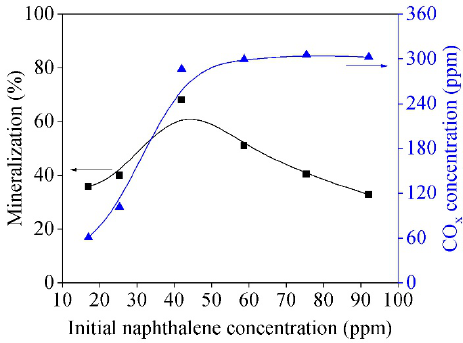
Figure 5. Effect of initial naphthalene concentration on the mineralization and CO x concentration in a DBD reactor filled with Al 2 O 3 . (Discharge power: 55 W; driving frequency: 12.6 kHz; initial naphthalene concentration: 21.5 ppm; total gas flow rate: 500 mL/min; discharge gap: 3 mm).